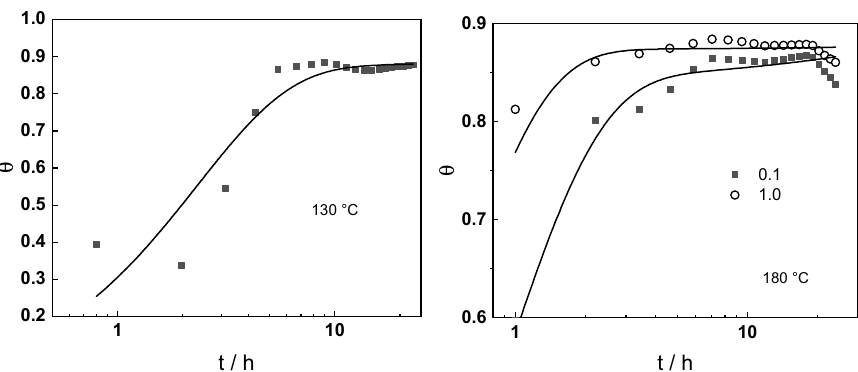
Figure 9. Time dependence of the degree of coverage with magnetite at 130 ( left ) and 180 ° С ( right ) in the presence of 0.1 and 1.0 g dm − 3 Fe 3 O 4 in the electrolyte. Points—experimental data, lines—best-fit calculation according to the equation. Table 3. Best-fit values of kinetic parameters of deposition, detachment and consolidation of mag- netite on AISI 316L in the AMETA coolant at 130 and 180 ° С .